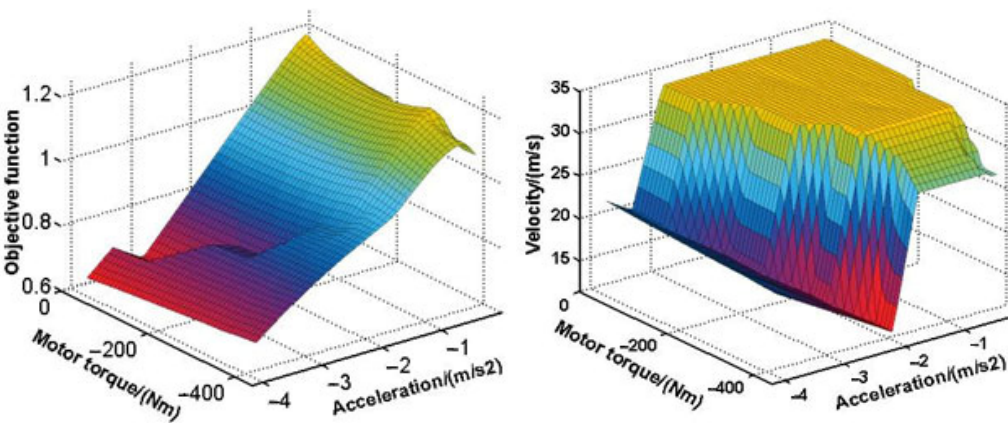
Figure 12. Gear shifting schedule in different gears (5 to 4).